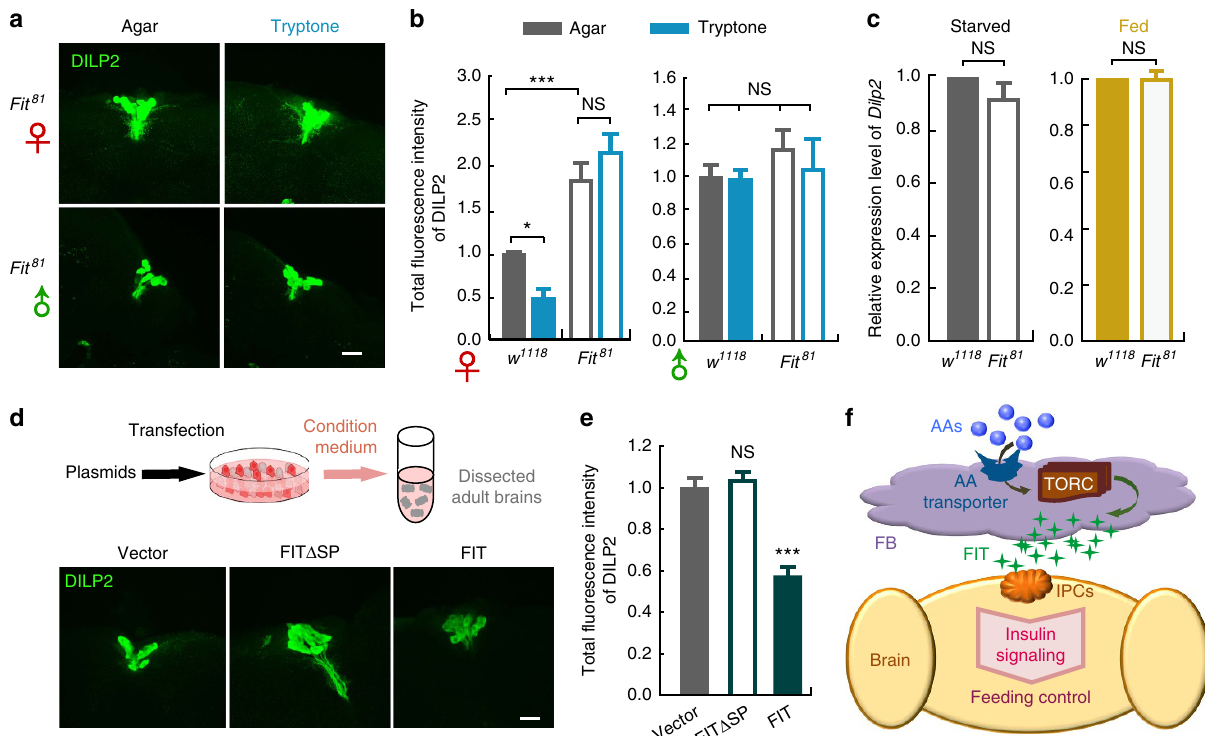
Figure 7 | Secreted FITpeptide is responsible and sufficient to induce DILP2 release. ( a , b ) DILP2 signal in Fit 81 female flies did not decrease after 30min feeding of tryptone. n ¼ 20–42 for female groups, n ¼ 19–33 for male groups. P(Food*Genotype) ¼ 0.0177 in female, P(Food*Genotype) ¼ 0.6906 in male (two-way ANOVA, Bonferroni test). Scale bar, 20 m m. ( c ) The mRNA levels of Dilp2 in fly heads were comparable in Fit 81 and WT female flies. Data were analysed by unpaired Student’s t -test. n ¼ 3. ( d , e ) DILP2 fluorescent signal in brains incubated with FITconditioned medium was significantly lower than that with either the empty vector or FIT D SP. n ¼ 22–47. One-way ANOVA, LSD’s post hoc test. Scale bar, 20 m m. ( f ) Diagram of FIT function across two organs. In response to increased AA levels, FIT is expressed and secreted from the FB, and regulates feeding behaviour via CNS insulin signalling. * P o 0.05; *** P o 0.001. NS indicates no statistical significance. The data are mean ±